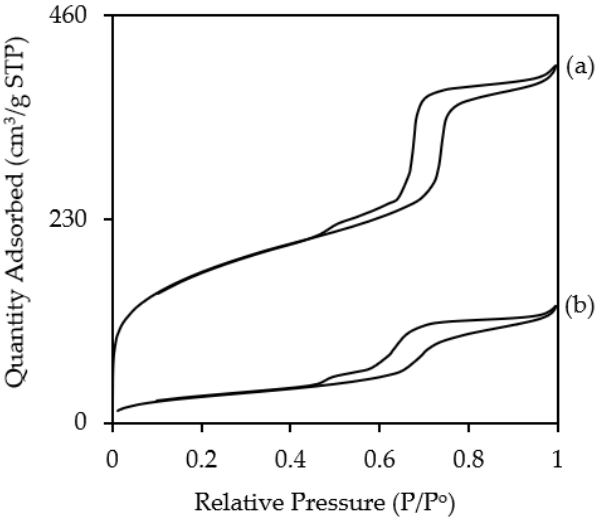
Figure 4. Nitrogen adsorption – desorption isotherm of ( a ) KIT-6 and ( b ) NH 2 KIT-6.